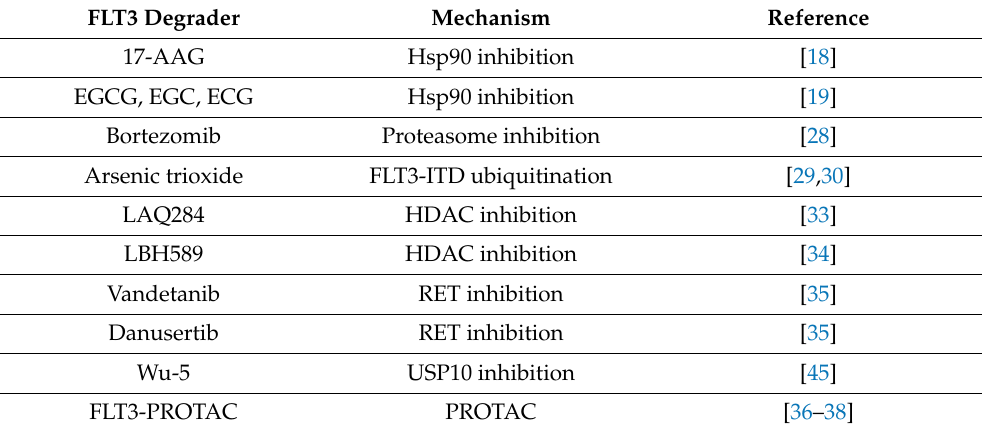
Table 1. Small molecules inducing FLT3 degradation.